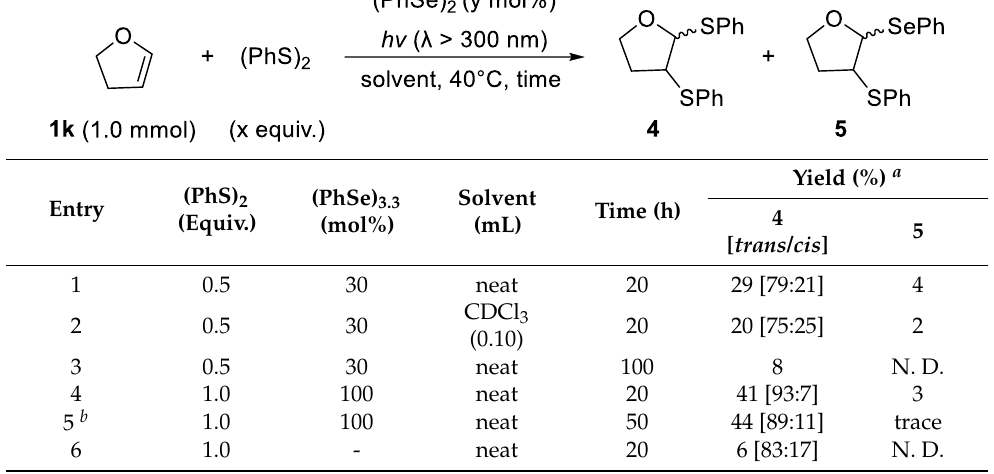
Table 2. Attempted dithiolation of styrene 1j assisted by (PhSe) 2